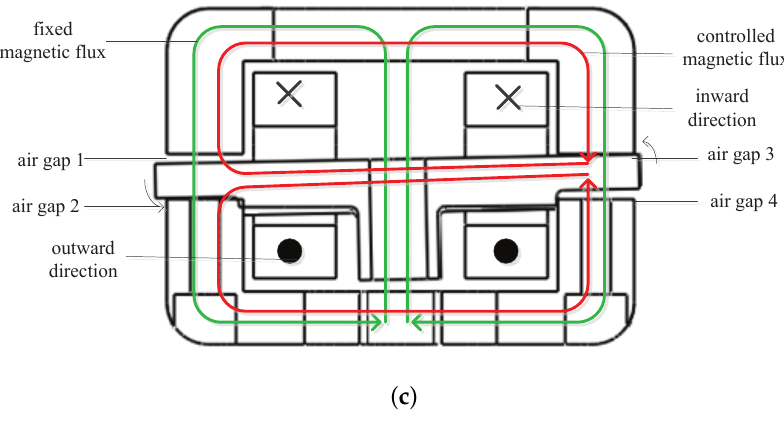
Figure 2. Magnetic flux loop and operating principle of the torque motor. ( a ) Magnetic circuit when there is no current in coils. ( b ) Magnetic circuit when the coils are supplied with power. ( c ) Magnetic circuit when the current reverses the